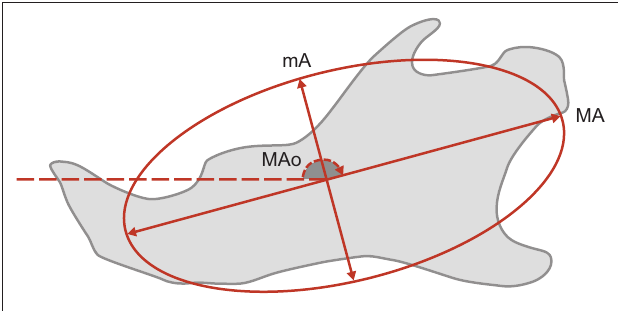
Figure 3 | each harmonic corresponded to an ellipse summarized by three elliptical descriptors: major axis length (MA), minor axis length (mA), and orientation of the major axis of the ellipse (MAO). The orientation of the ellipse corresponds to the angle formed by the major axis and the horizontal reference axis.